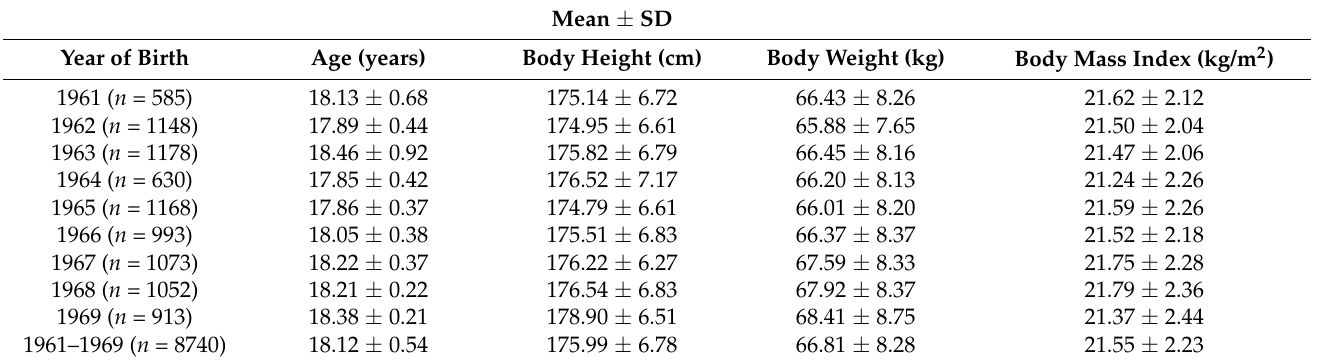
Table 1. Descriptive data of young males from the Municipality of Berane enrolled in the study.